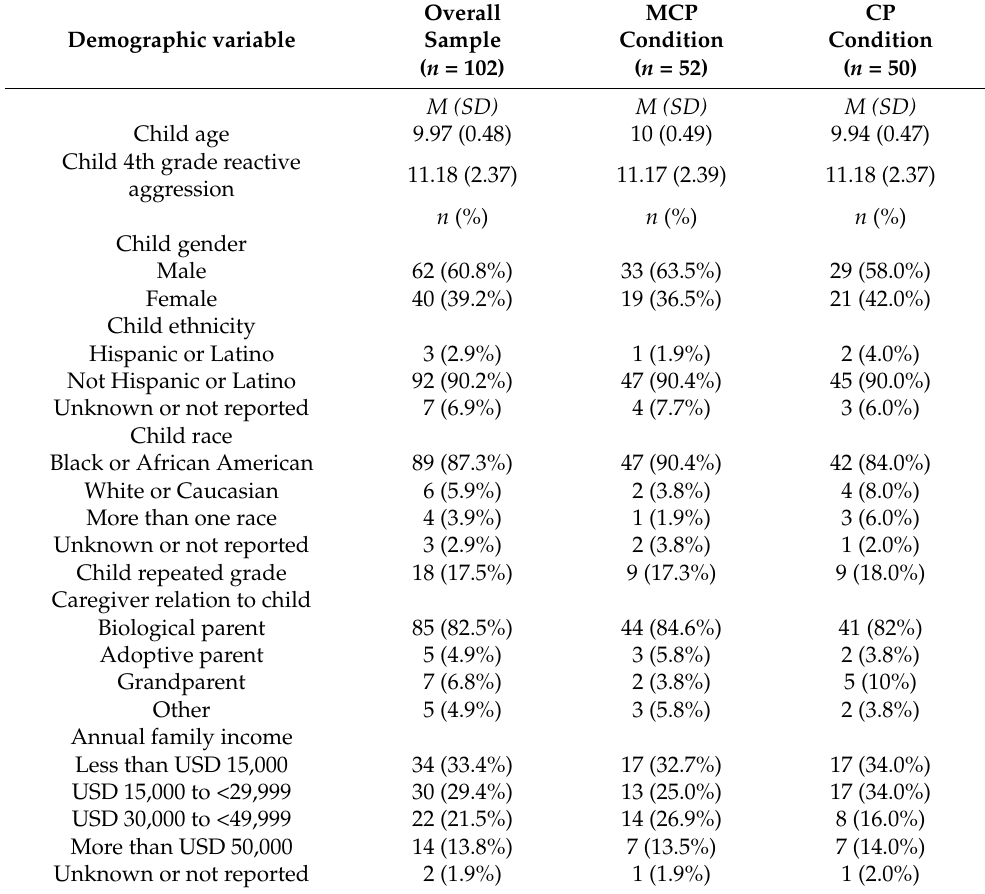
Table 1. Participant characteristics at time of